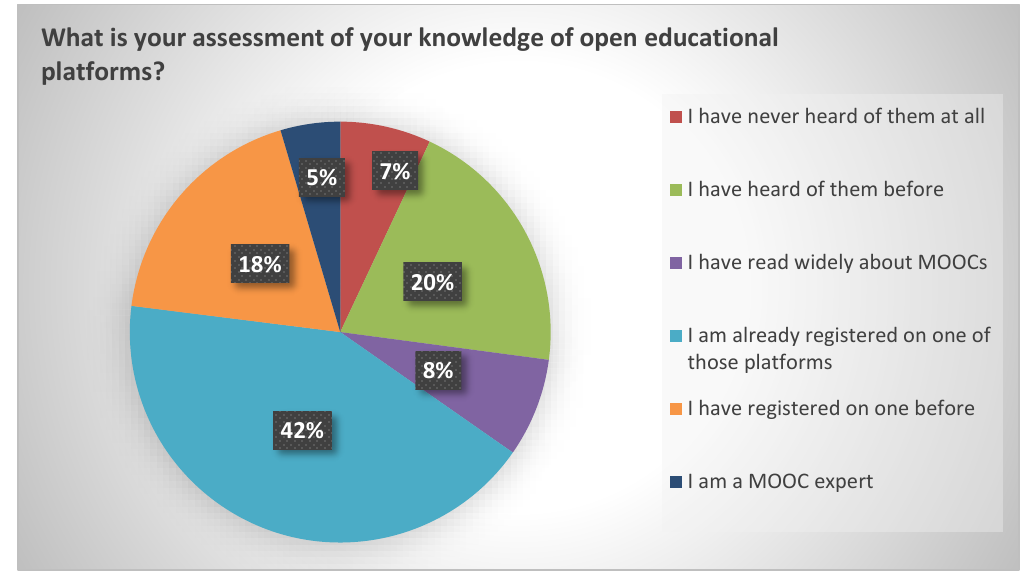
Figure 3. Percentages of students’ responses concerning open educational